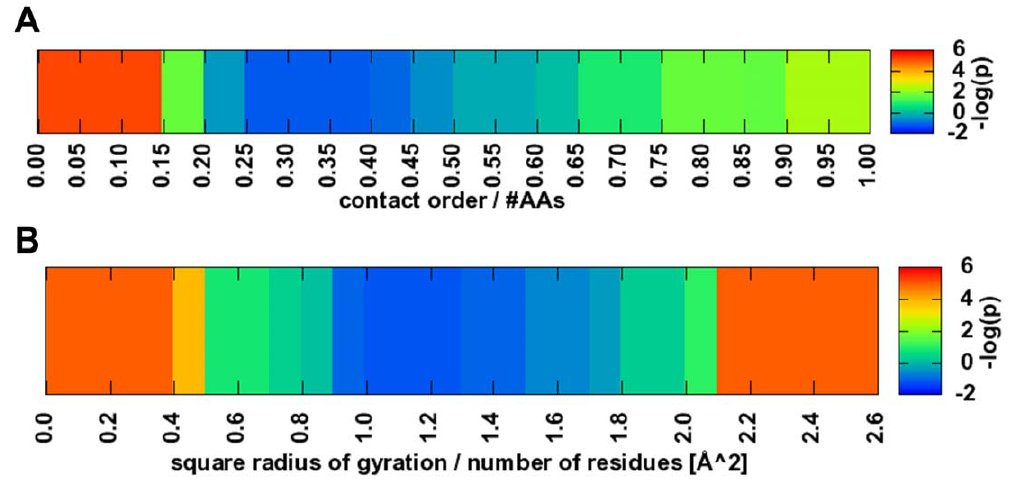
Figure 6. Contact order and square radius of gyration potential. A Fold complexity is represented by the contact order potential. The potential is given as the likelihood to observe a contact order to number of residues ratio in the model. B Statistics for the square radius of gyration over the number of residues were directly collected in a histogram and converted into a potential.